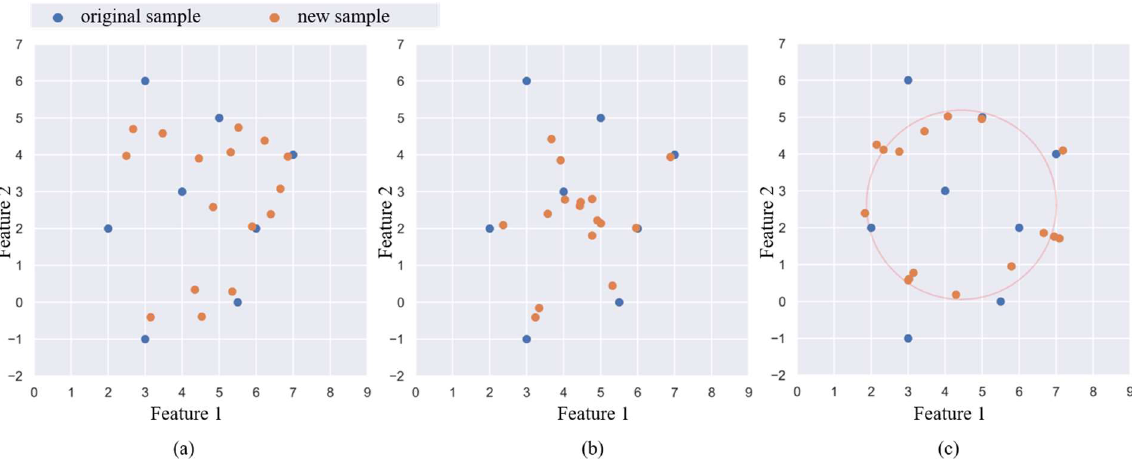
Figure 3. New samples on oversampling algorithms: ( a ) SMOTE, ( b ) LR-SMOTE, ( c ) MeanRadius-